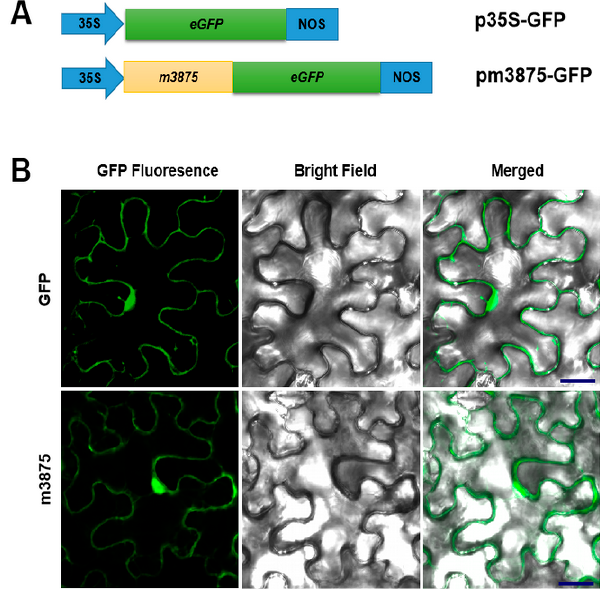
Figure 2. Subcellular localization of m3875 in Nicotiana benthamiana . ( A ) Diagrams of the expression cassettes for green fluorescent protein (GFP) and the fusion gene m3875-GFP . The CaMV 35S promoter is designated 35S, and the nopaline synthase terminator is designated NOS. ( B ) Fluorescence of the transiently expressed m3875-GFP in epidermal cells of the N. benthamiana leaves. p35S-GFP and pm3875-GFP were individually introduced into the five-leaf stage N. benthamiana plants grown at 25 °C via agroinfiltration, and the GFP fluorescence was viewed by confocal microscopy after 48 h post inoculation. Scale bars represent 20 μ m.